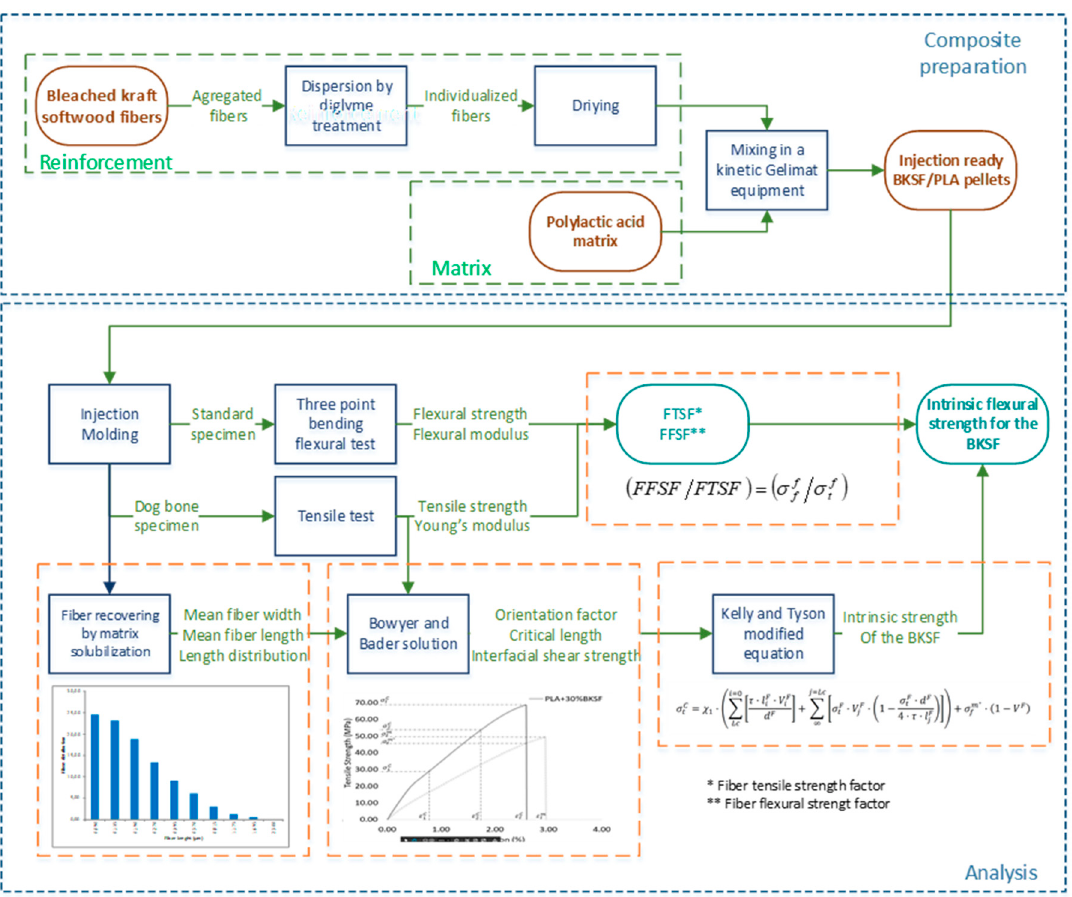
Figure 1. Flowchart of the research, including the preparation and mechanical properties test phases.